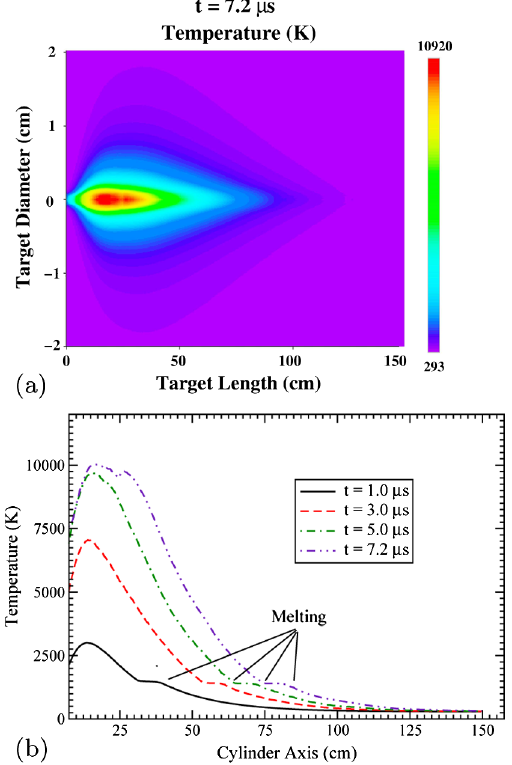
FIG. 11. (a) Specific energy distribution in the cylindrical copper target, r ¼ 5 cm , L ¼ 1 : 5 m , irradiated by the 440 GeV SPS proton beam with (cid:1) ¼ 0 : 5 mm at t ¼ 7 : 2 (cid:2) s (end of the beam) and (b) specific energy deposition profiles along the axis at different times